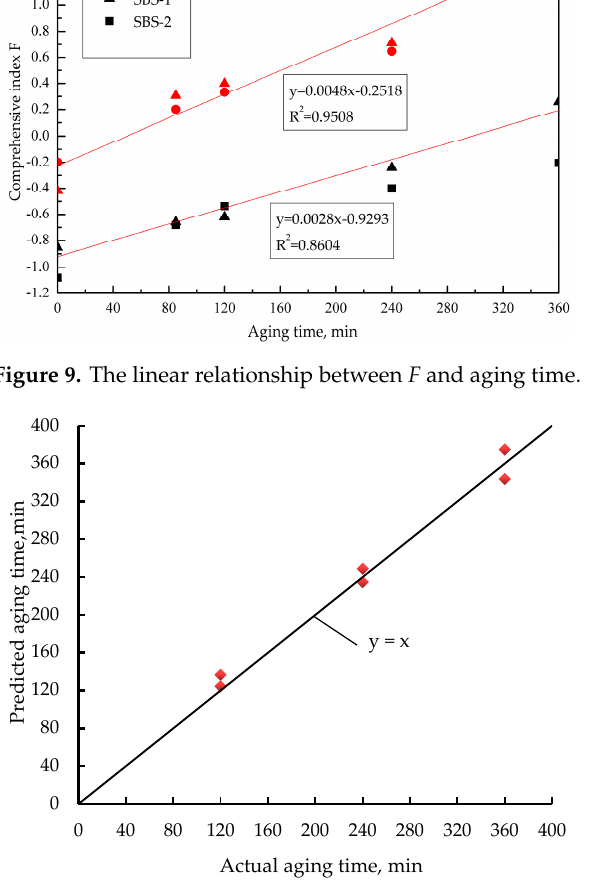
Figure 10. The validation of the asphalt aging time prediction model.